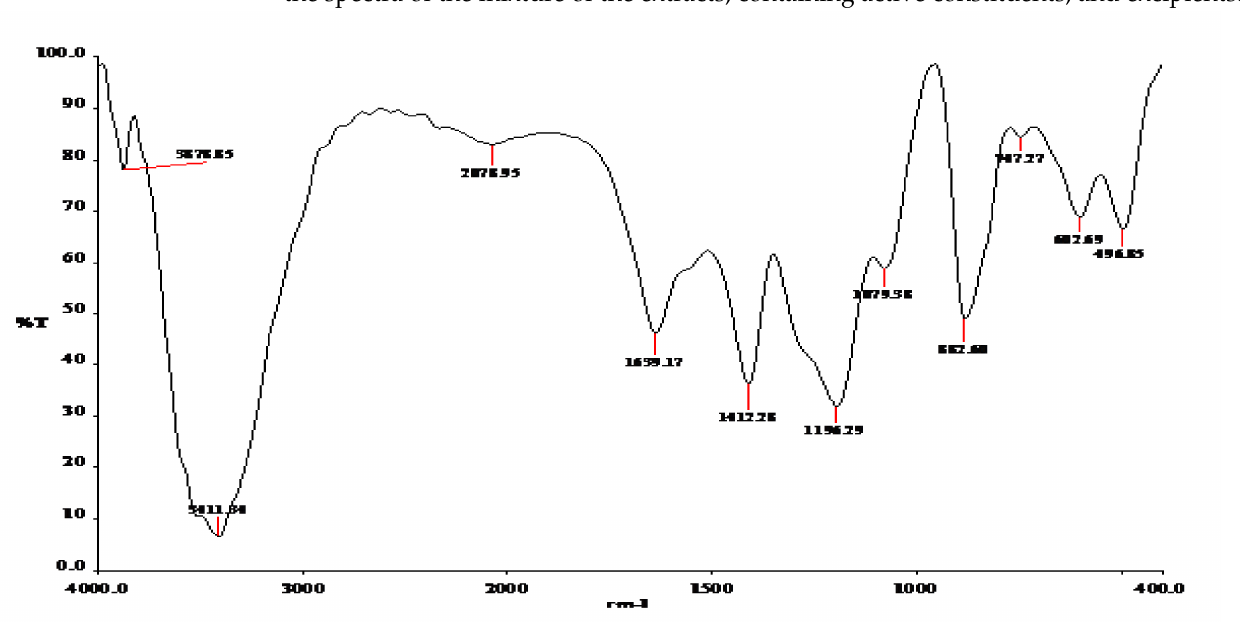
Figure 4. FTIR spectra of NEI5.